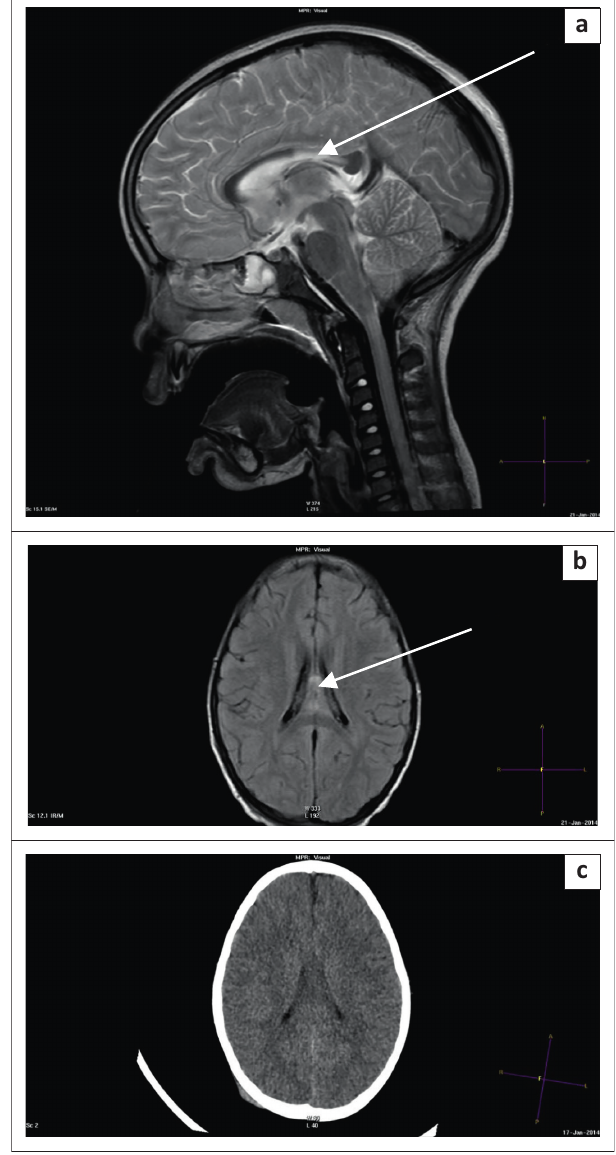
FIGURE 9: (a) A 9 year old girl presented with a head injury (GCS 8T), and suspected cervical spine injury. Sagittal T2 weighted MRI (large open field view) showed a corpus callosum shearing injury, with high signal in the body and extending to the splenium (white arrow). The cervical spine was normal; (b) Axial FLAIR MRI confirmed the high signal in the body of the corpus callosum (white arrow); (c) Review of axial CT brain on admission showed no features of callosal